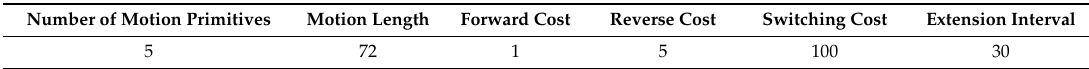
Table 2. Simulated haulage truck parameters. Table 3. Hybrid A* algorithm parameters.